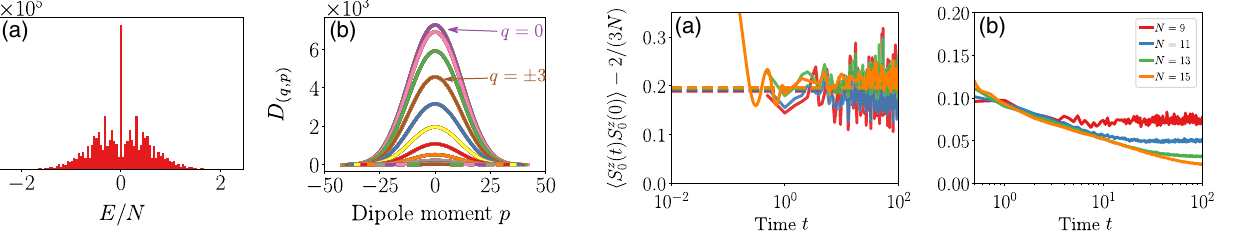
FIG. 13. Finite-size scaling for the autocorrelation function h S z 0 ð t Þ S z 0 i at an infinite temperature in the full Hilbert space after substracting the thermal value. (a) shows a finite value for the autocorrelation under the evolution of H 3 in Eq. (1). The dashed lines show the lower bound in Eq. (B1). (b) The autocorrelation function decays to zero with the system size once the longer- range interaction H 4 in Eq. (2) is added to H 3 .